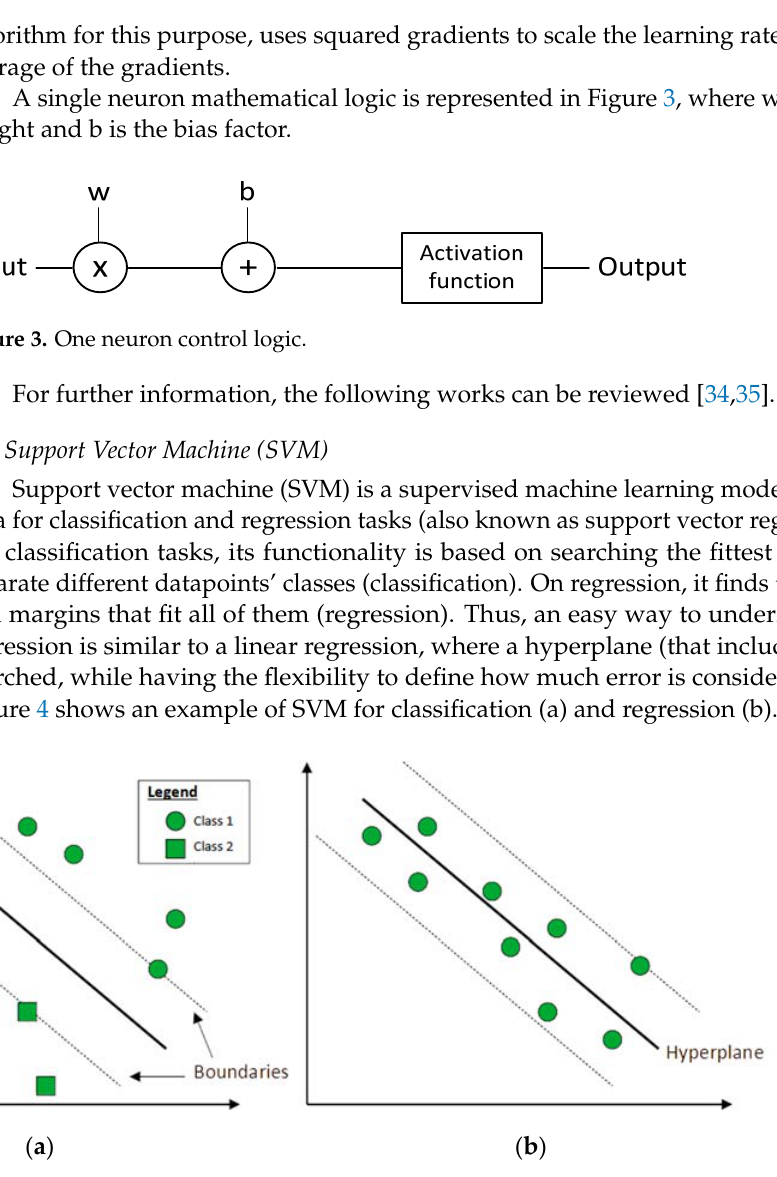
Figure 4. Support Vector Machine for classification ( a ) and regression ( b ) .